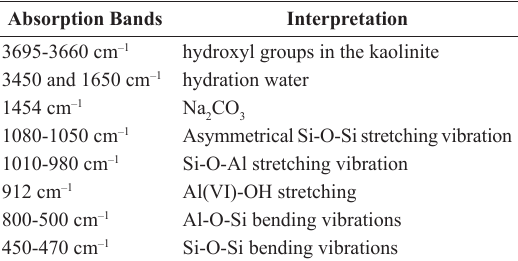
Table 3. IR characteristic bands and their